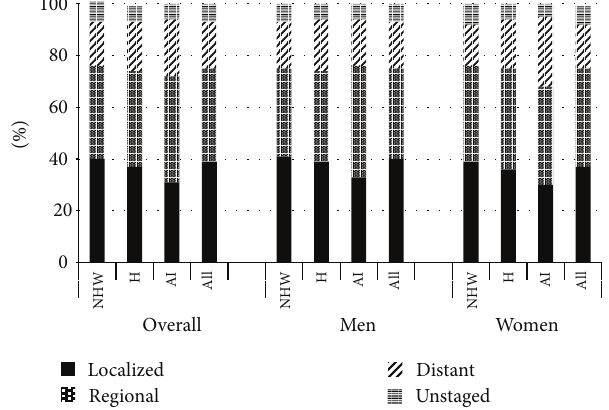
Figure 3: New Mexico colorectal cancer stage distribution by race/ethnicity and gender, 1995–2009. NHW: non-Hispanic white, H: Hispanic, and AI: American Indian. Columns do not all sum to 100% due to